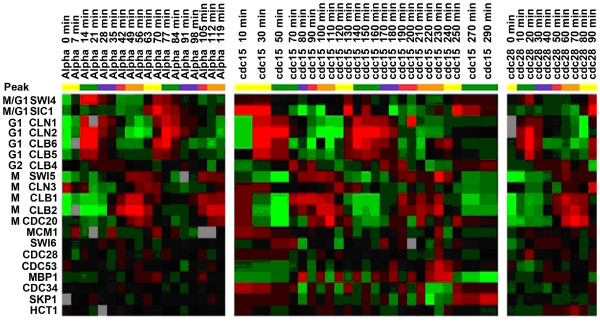
Gene expression during the yeast cell cycle. In this figure, each gene corresponds to a row, and the time point for each column is denoted. The magnitude of mRNA expression ratio for each gene is represented by different colours. Red indicates mRNA abundance; green indicates a dearth; and gray indicates absence of the data. The colours at the top bar distinguish the cell cycle phases (M/G1, yellow; G1, green; S, purple; G2, red; M, orange).